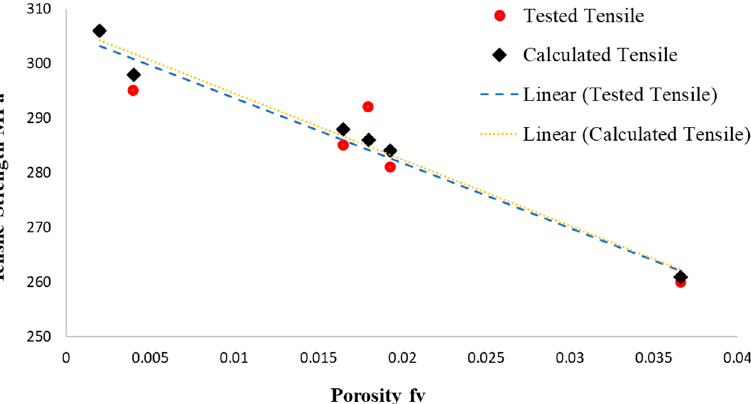
Figure 17. Calculated Tensile Strength vs. Calculated Porosity Parameter for 1 mm/min Stroke Speed Tests. Speed